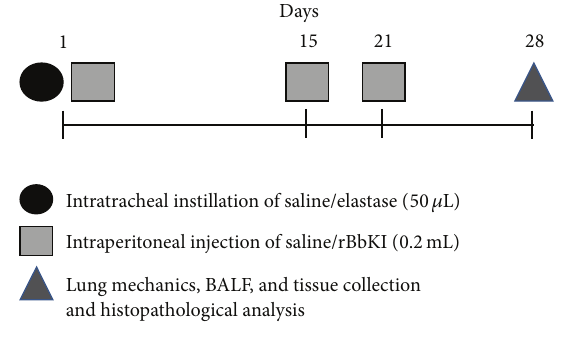
Figure 2: Timeline of the experimental